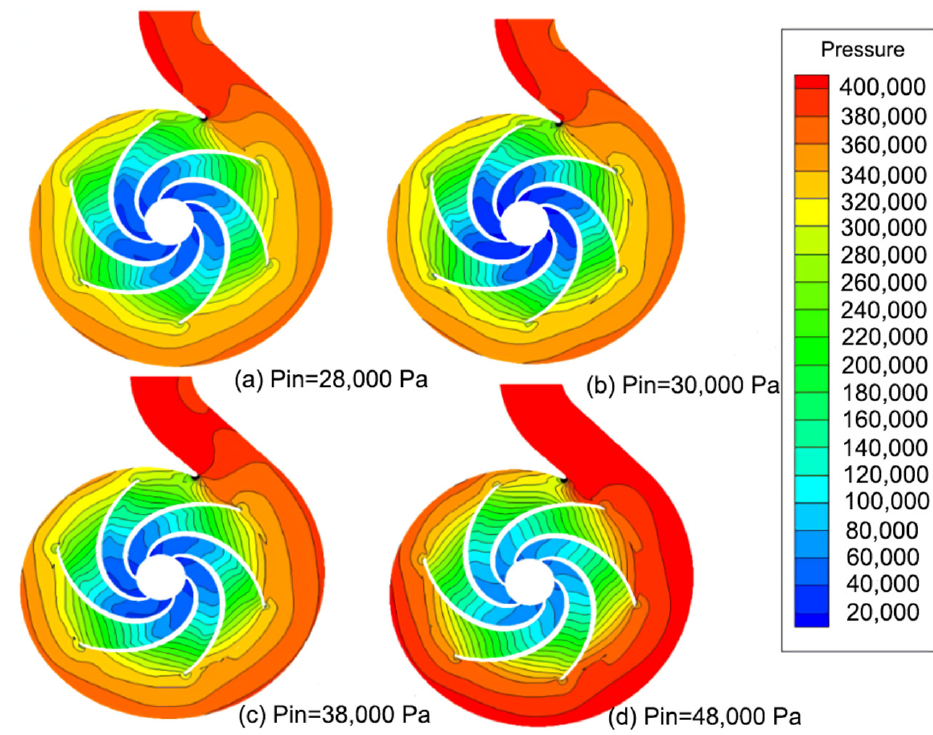
Figure 6. Static pressure distribution of centrifugal pumps at different NPSHs.